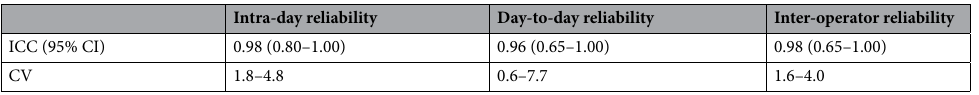
Table 1. Intra- and inter-operator reliabilities of agar phantom gel elasticity. The intra-class correlation coefficient (ICC), 95% confidence interval (CI), and coefficient of variation (CV) were calculated for each trial. Phantom gels with different concentrations of agar (1%, 2%, 3%, 4%, and 8%) were measured twice per day for 2 days with a between-measurement interval of 1 day (three measurements per